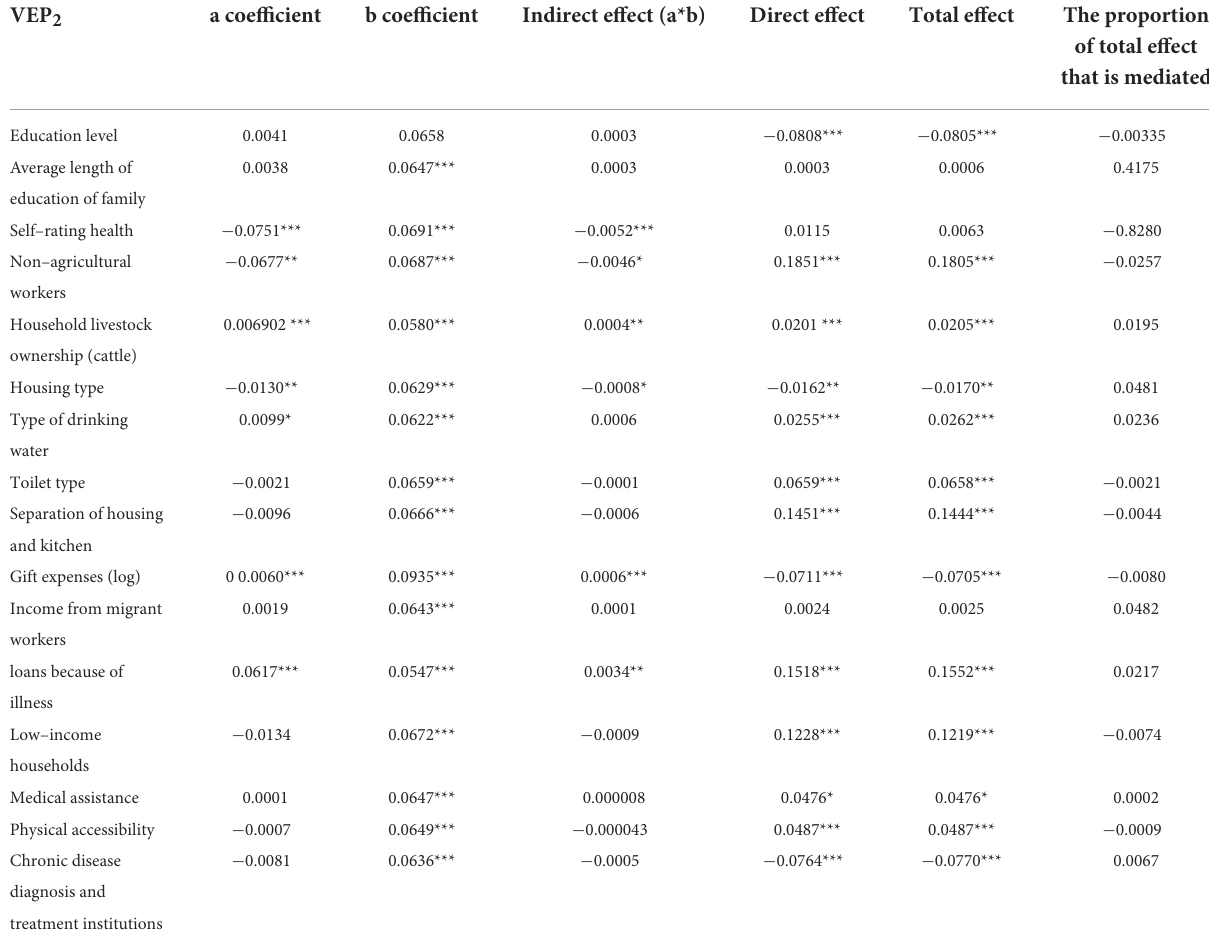
TABLE 5 Intermediary effect test of vulnerability to poverty related to the physical multimorbidity. VEP